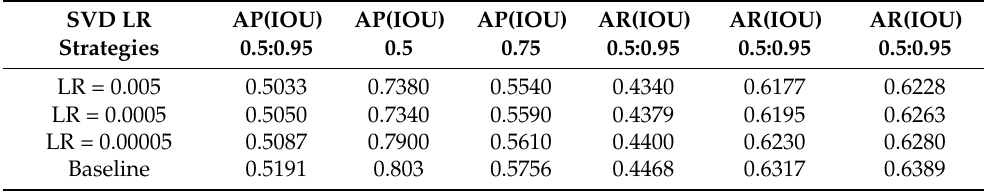
Table 6. SVD performance on learning rate decade strategies.